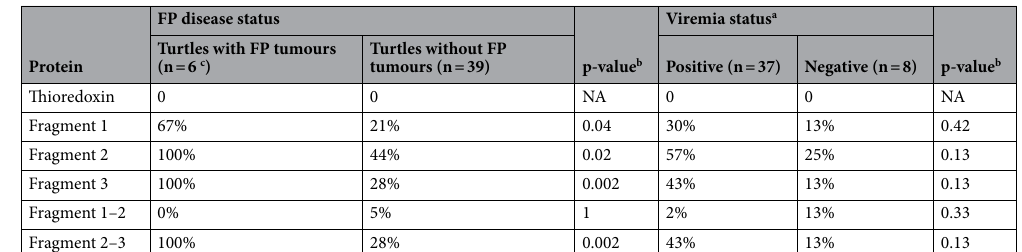
FP disease status